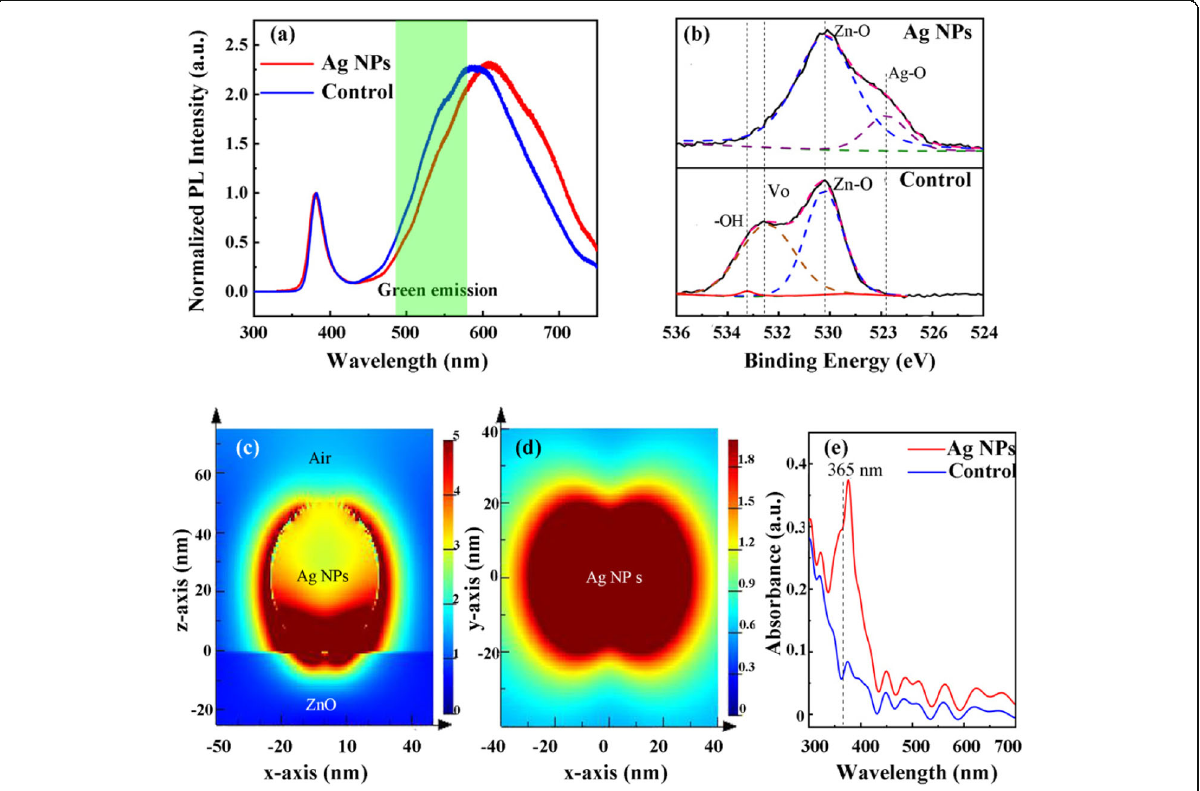
Fig. 2 a The Normalized PL intensity of ZnO films with and without Ag NPs. b XPS spectra corresponding the O-1s core level of ZnO film with and without Ag NPs. c The cross-section electric field distributions and d the top view electric field distributions of Ag NPs on ZnO film simulated by FDTD. e The absorption curves of ZnO film with and without Ag NPs calculated by FDTD. Liu et al.